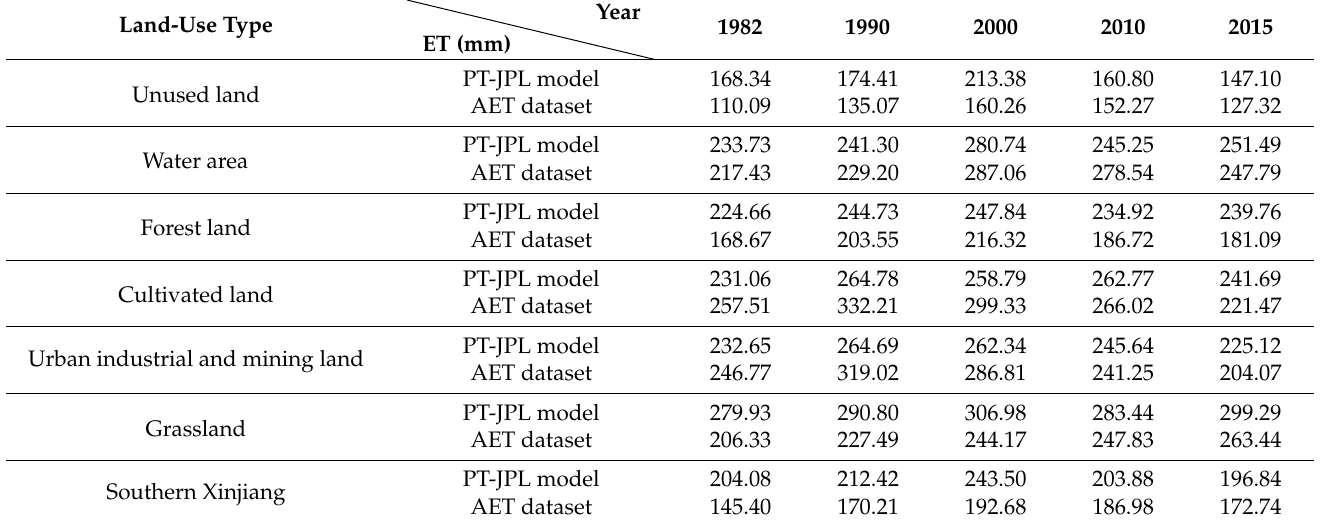
Table 3. Annual evapotranspiration data of different land-use types in the AET dataset and the PT-JPL